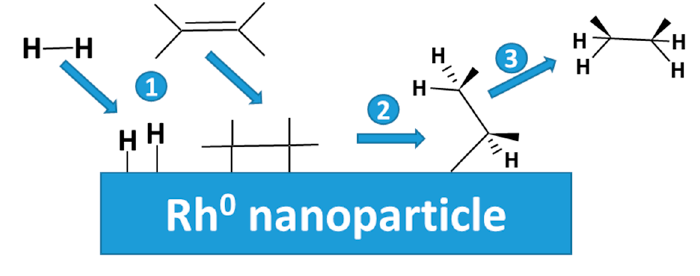
Figure 12. The proposed mechanism for the hydrogenation of cyclohexene over Rh-TUD-1.